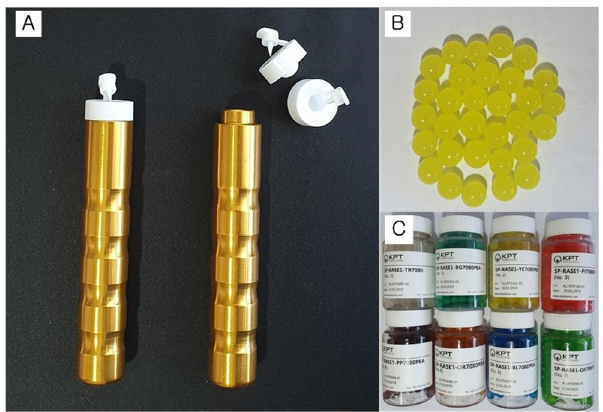
Fig 1. A novel olfactory threshold test kit, Sniff Bubble . (A) Aluminum-made bodies and disposable plastic capsule containers. (B) Rose odor-containing beads made with 2-phenylethyl alcohol (PEA). (C) Eight types of beads with the seven PEA concentrations ranging from 10%–0.16% and distilled water.